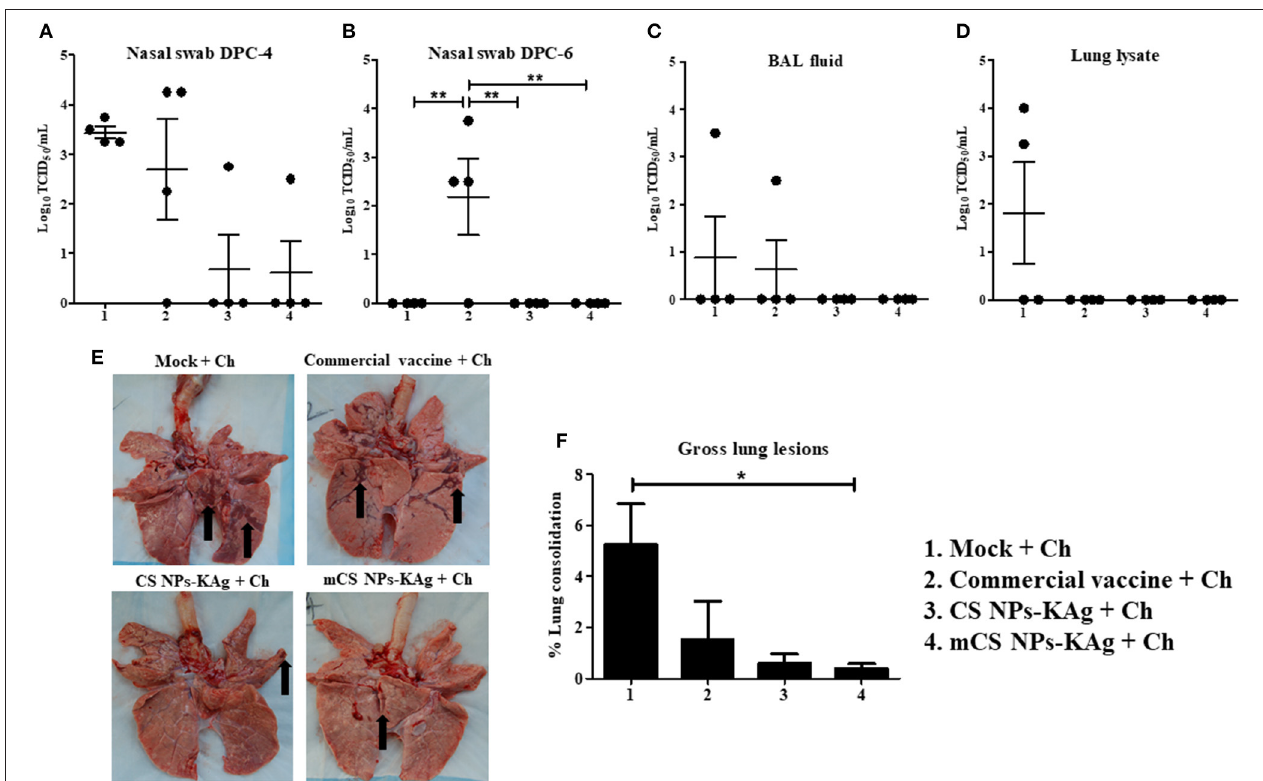
FIGURE 6 | Mannose-conjugated and unconjugated CS NPs based influenza (mCS NPs-KAg and CS NPs-KAg) vaccines reduced/cleared the heterologous challenge H1N1 virus in MDA-positive pigs. Pigs were prime-boost vaccinated with mCS NPs-KAg and CS NPs-KAg vaccines (containing H1N2-OH10 virus) intranasally or commercial vaccine (containing H1N1, H1N2 and H3N2 viruses) intramuscularly and at day 35 post vaccination challenged with a heterologous H1N1-OH7 virus. At day post challenge (DPC)-4 and − 6 the live H1N1-OH7 virus titers were analyzed in (A,B) Nasal swab; (C) BAL fluid (DPC-6); and (D) Lung lysate (DPC-6). (E) Representative ventral lung picture of experimental pigs showing the dark brown sites of consolidation indicated by arrows. (F) Macroscopic lung lesions score. Data represent the mean value of three to four pigs ± SEM. Statistical analysis was carried out using one-way ANOVA followed by Tukey’s post hoc comparison test. Asterisk refers to statistical difference between the two indicated groups (* p < 0.05, and ** p < 0.01). Ch,